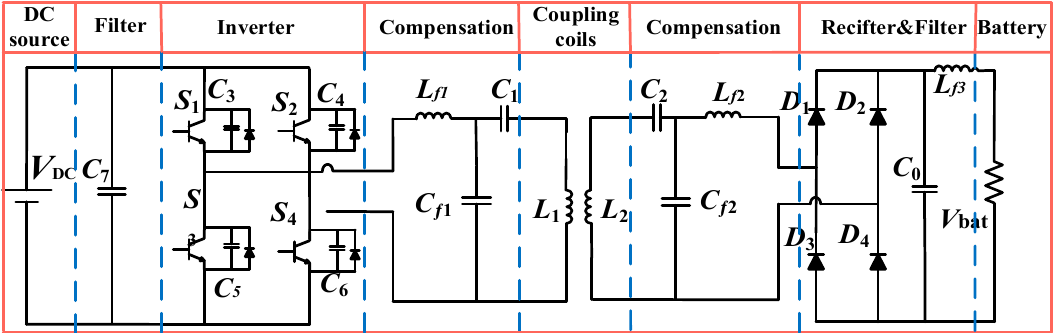
Figure 4. Construction of the WCS.